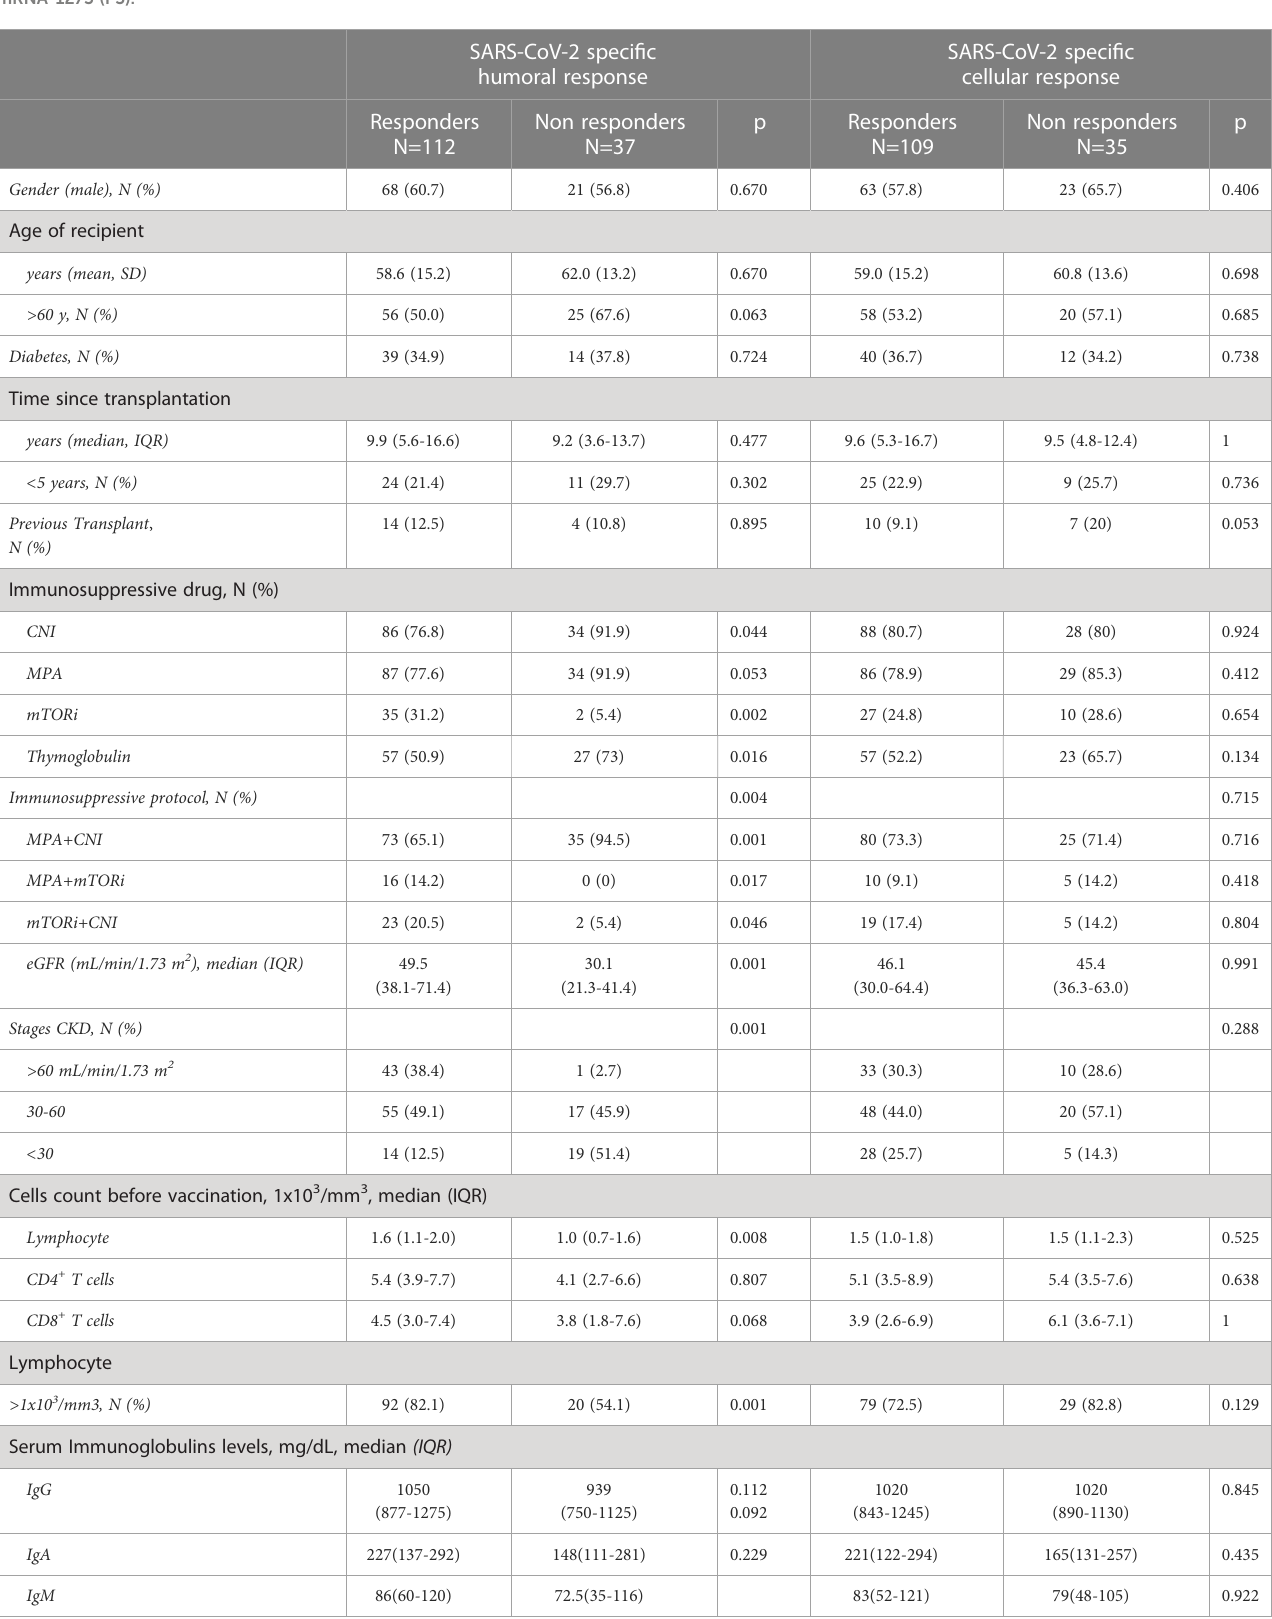
TABLE 1 Comparison of clinical characteristics between KTR who did or did not mount cellular and humoral response two months after 3 doses of mRNA-1273